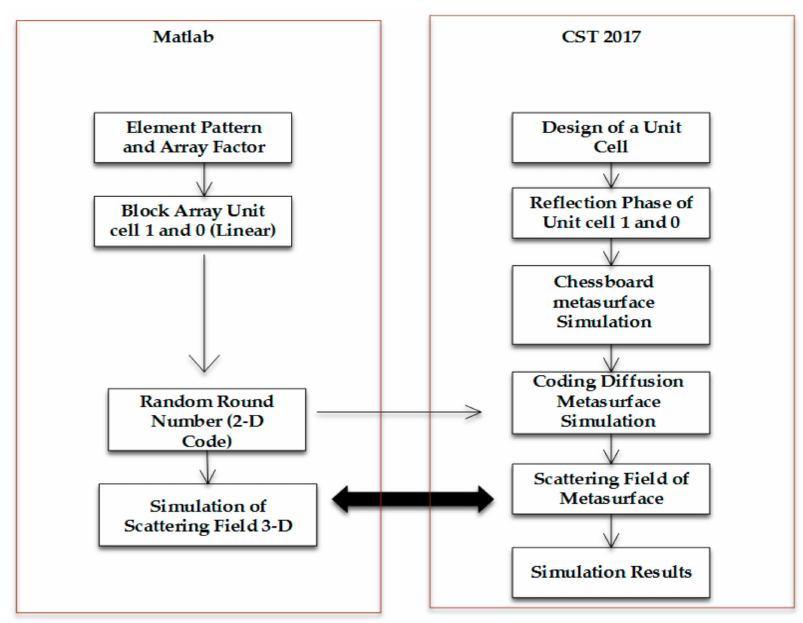
Figure 5. Flow chart of coding di ff usion metasurface.